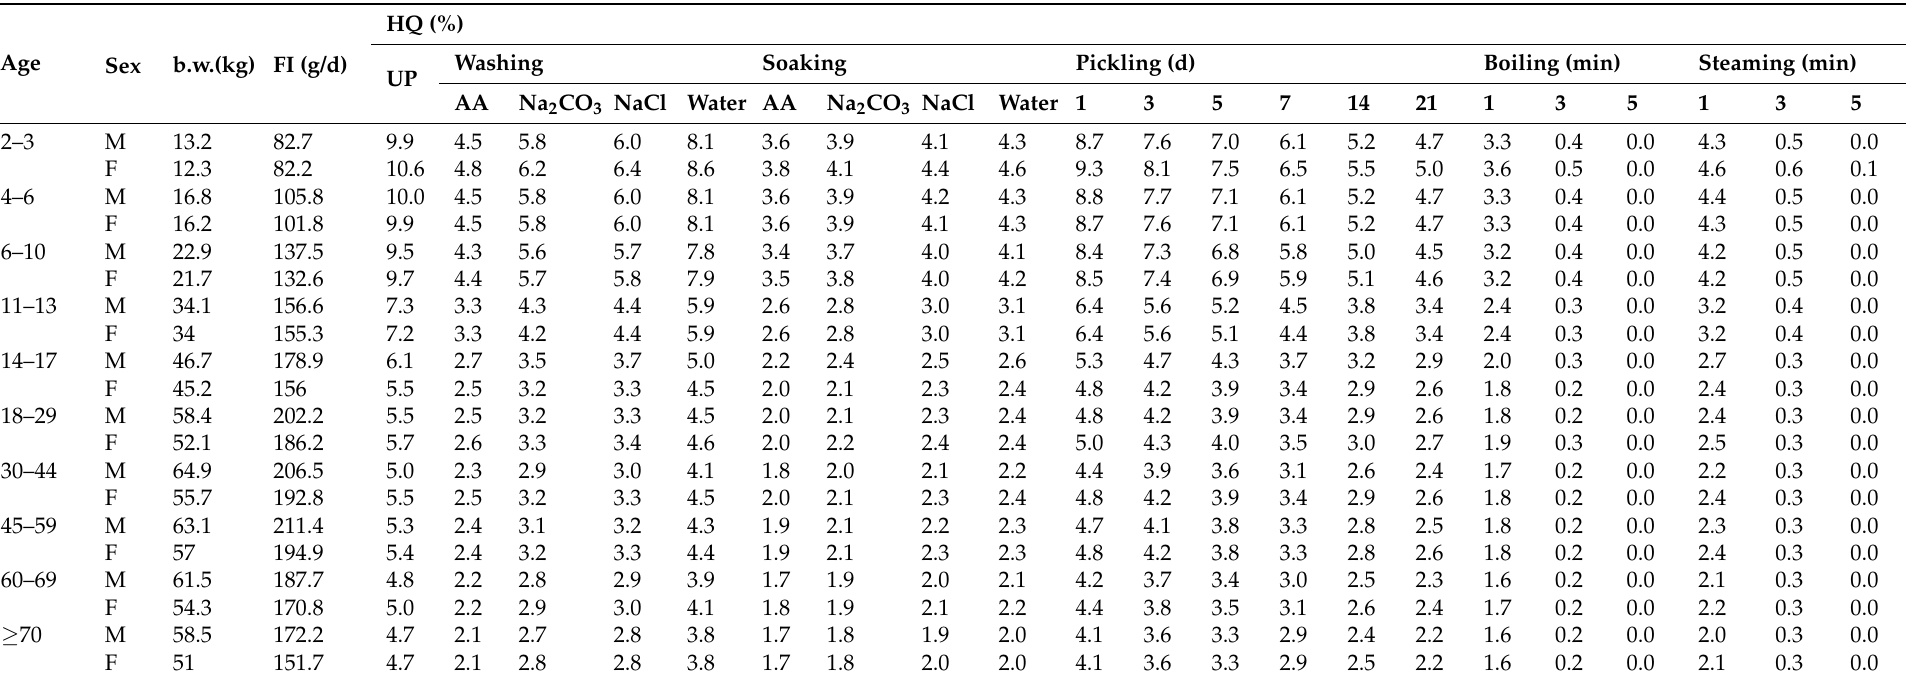
Table 9. Hazard quotient (HQ) of rac -mandipropamid in unprocessed (UP) and processing cowpea samples for different groups of Chinese